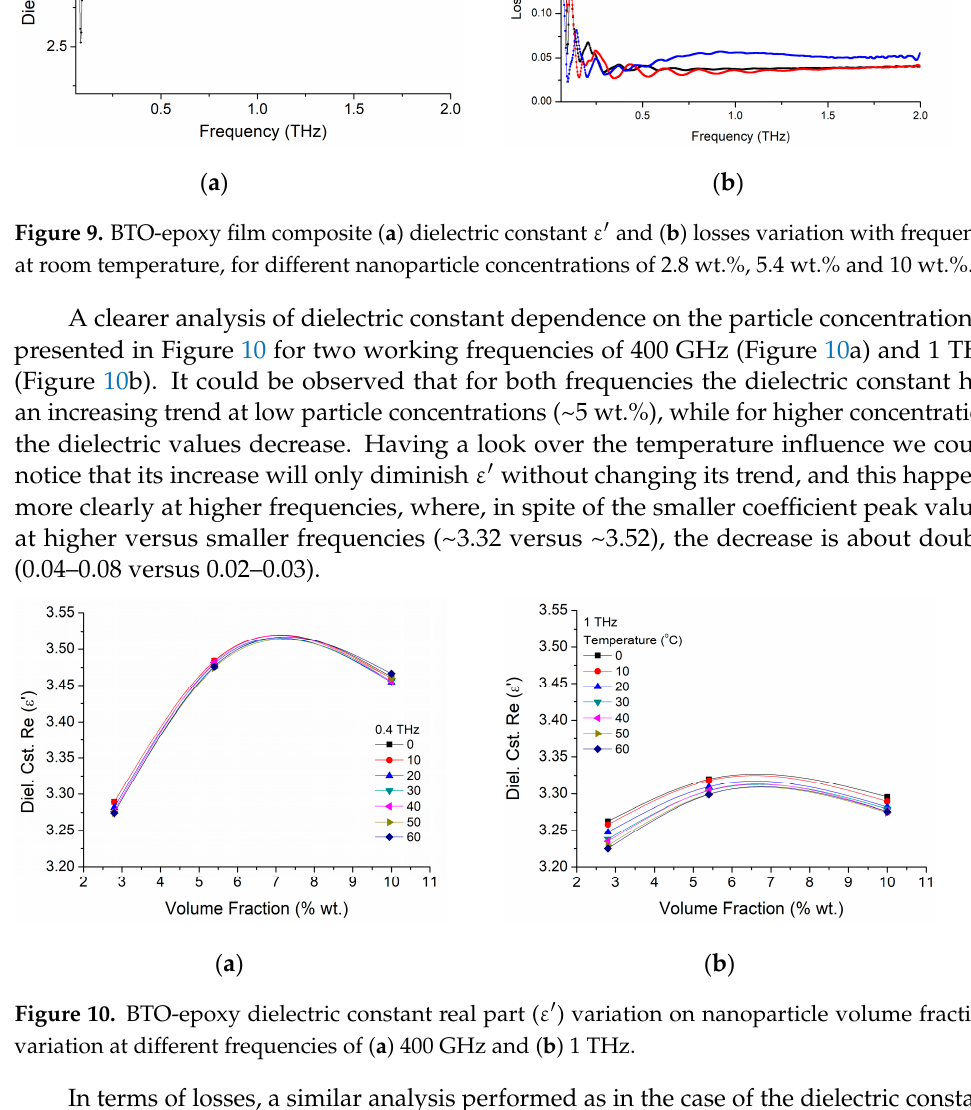
Figure 9. BTO-epoxy film composite ( a ) dielectric constant ε′ and ( b ) losses variation with frequency